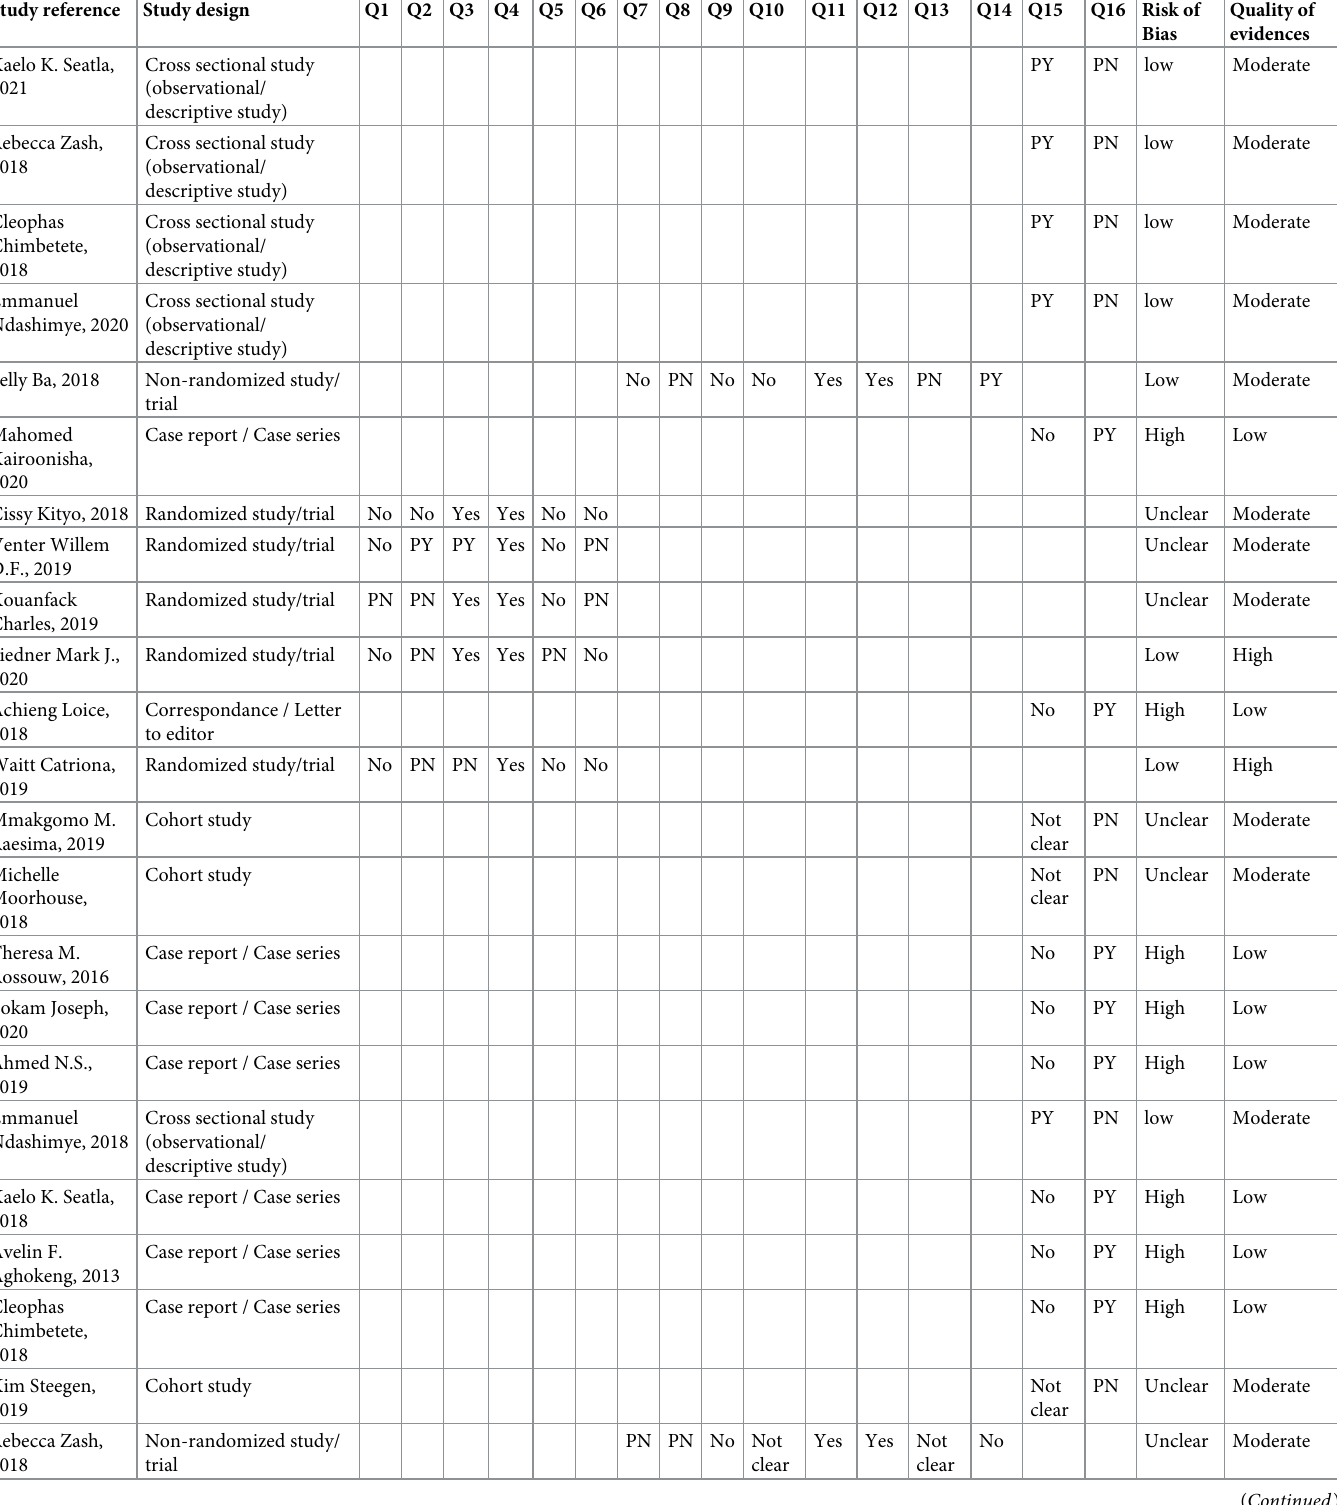
Table 2. Risk of bias